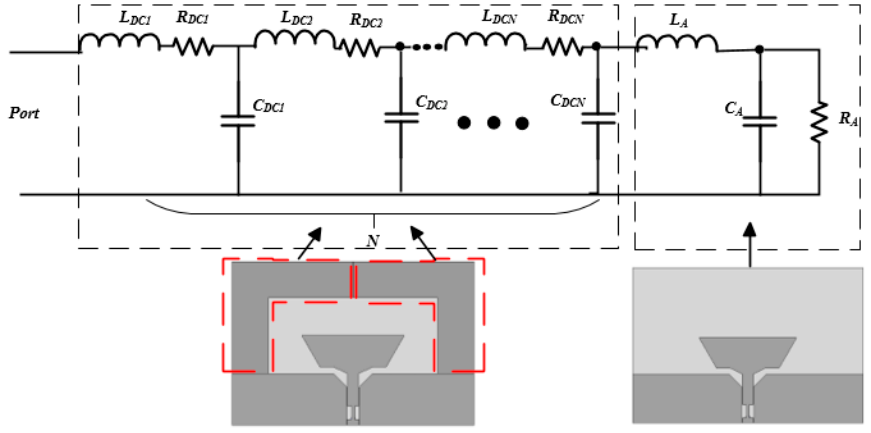
Figure 4. The equivalent circuit of the proposed BRA.